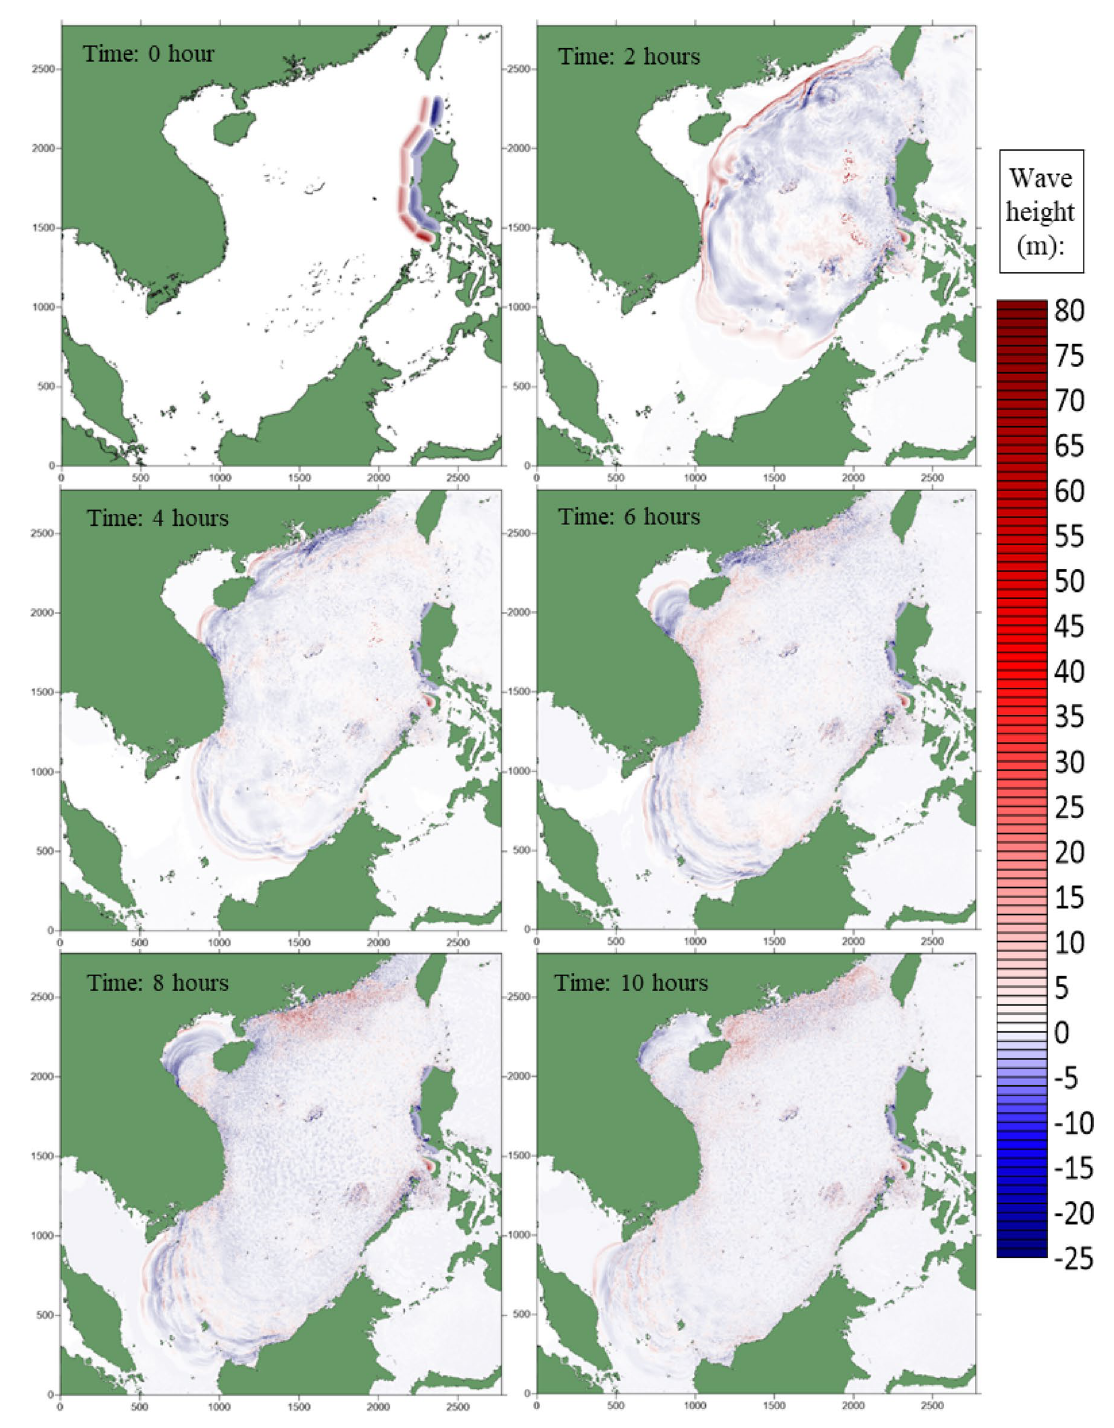
Fig. 4 Simulated tsunami wave propagation from Manila Trench earthquake